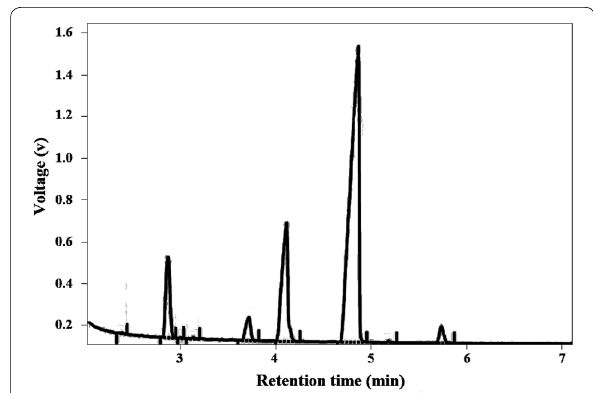
Fig. 3 Chromatogram of fatty acids in C. heratensis seed extract. (YL 6100 gas chromatograph system with a CBP5 column (Shimadzu